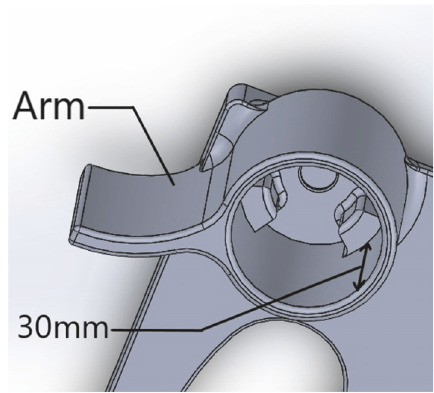
Figure 3: Side arm of